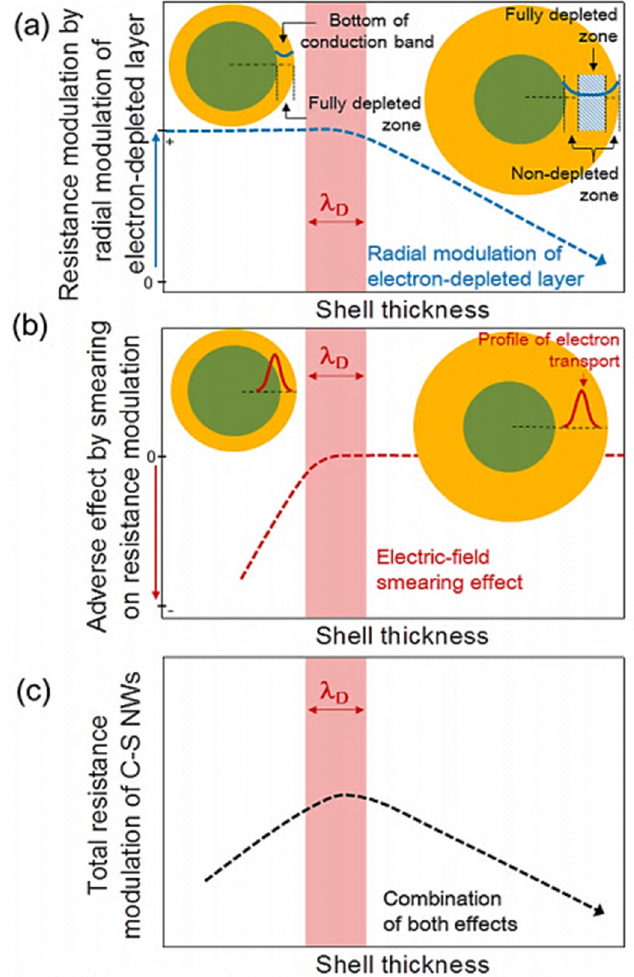
Figure 2. Conceptual explanation demonstrating the sensing mechanism of C-S NWs: ( a ) radial modulation, ( b ) adverse effect through smearing on resistance modulation, and ( c ) overall resistance modulation. Reproduced from [72] with the permission of the American Chemical Society.